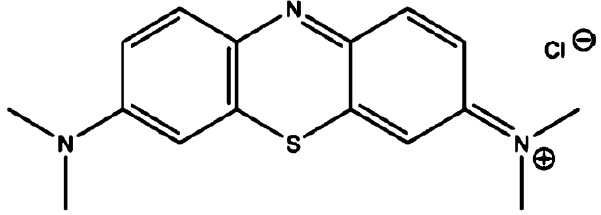
Figure 1. Chemical structure of